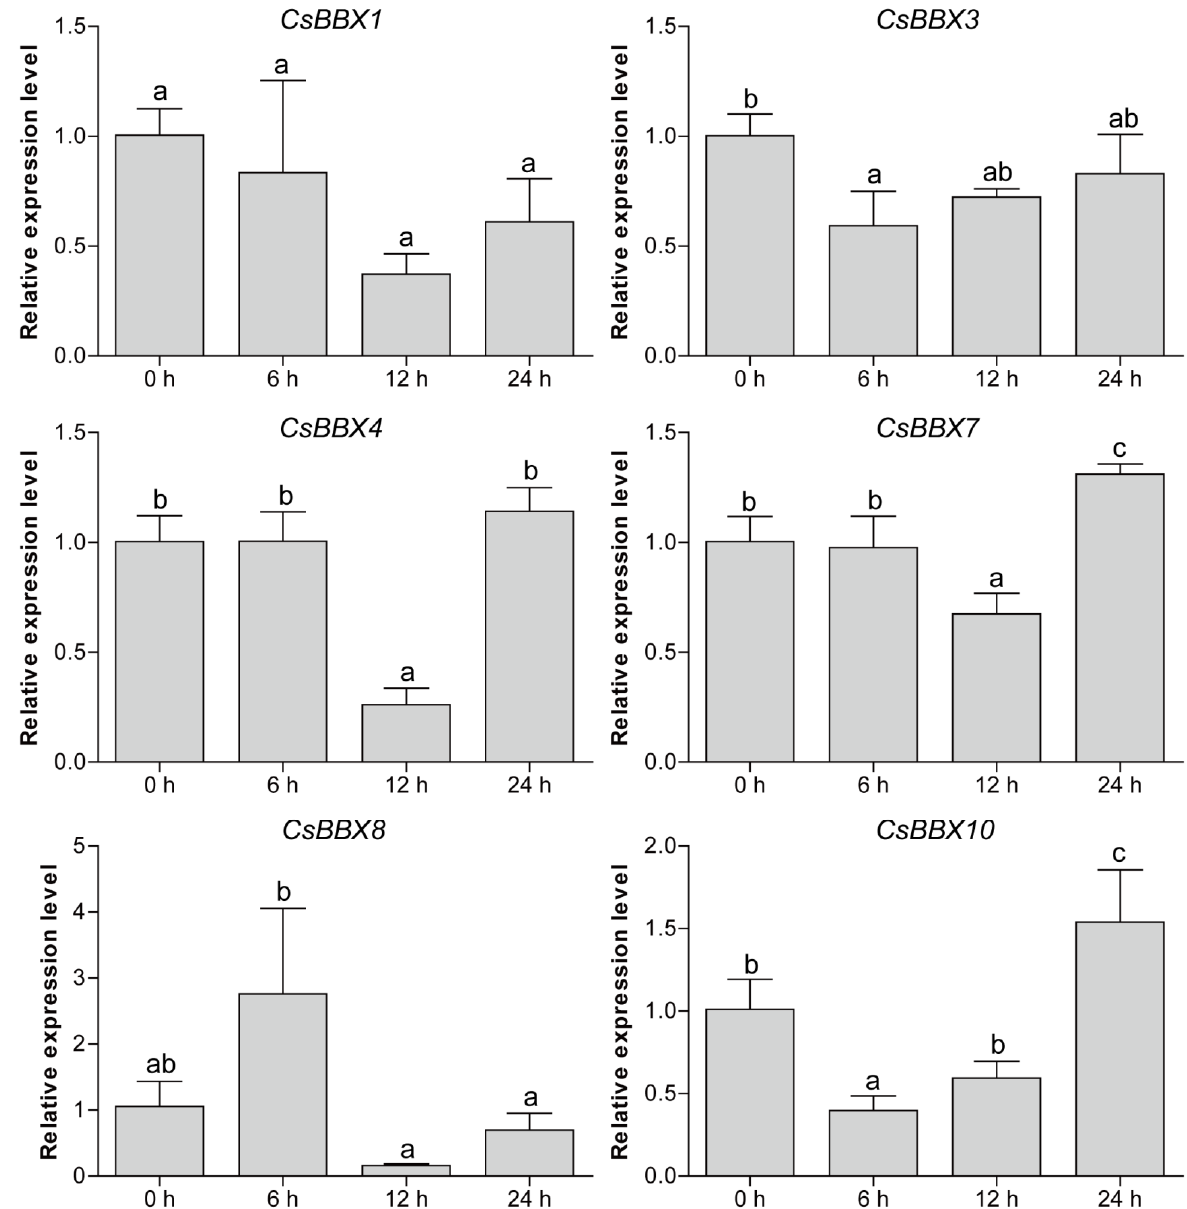
Figure 7. qRT-PCR analysis of six selected CsBBX genes under cold stress. The seedlings were kept at 4 °C for cold stress, and leaf samples were collected at 0, 6, 12, and 24 h. Data were normalized to the CsAct3 gene expression level, and the value of each CsBBX gene at 0 h was normalized as “1.0”. Different lowercase letters indicate significant differences among all the test data.